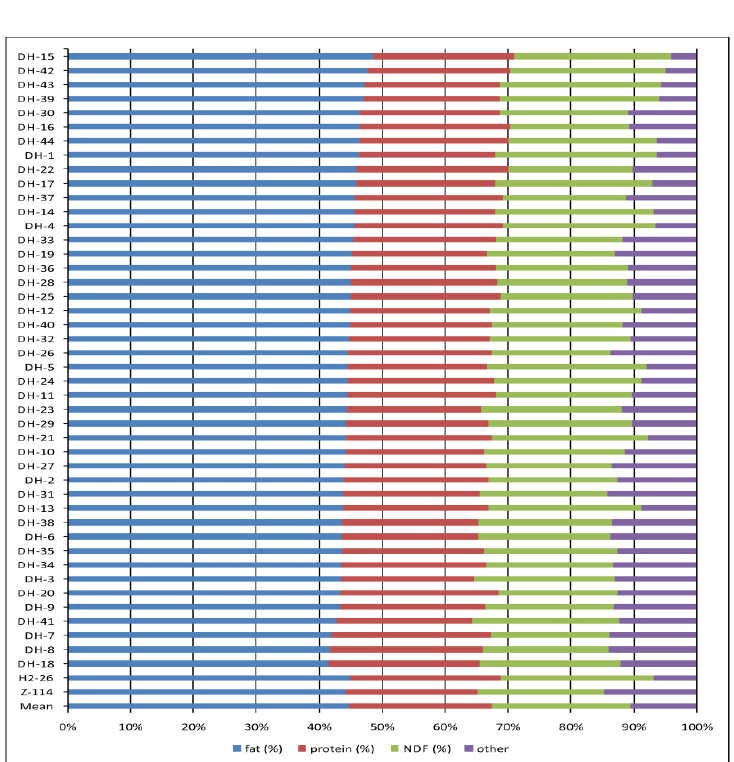
Figure 2. Frequency distribution of oilseed rape seed biochemical traits and seed colour for two years in the population of DH lines (no parental lines included). The ( A ) fat, ( B ) protein, ( C ), neu- tral detergent fibre — NDF ( D ) acid detergent fibre — ADF, ( E ) glucosinolates — GSL content, and ( F ) scaled seed colour values were shown.